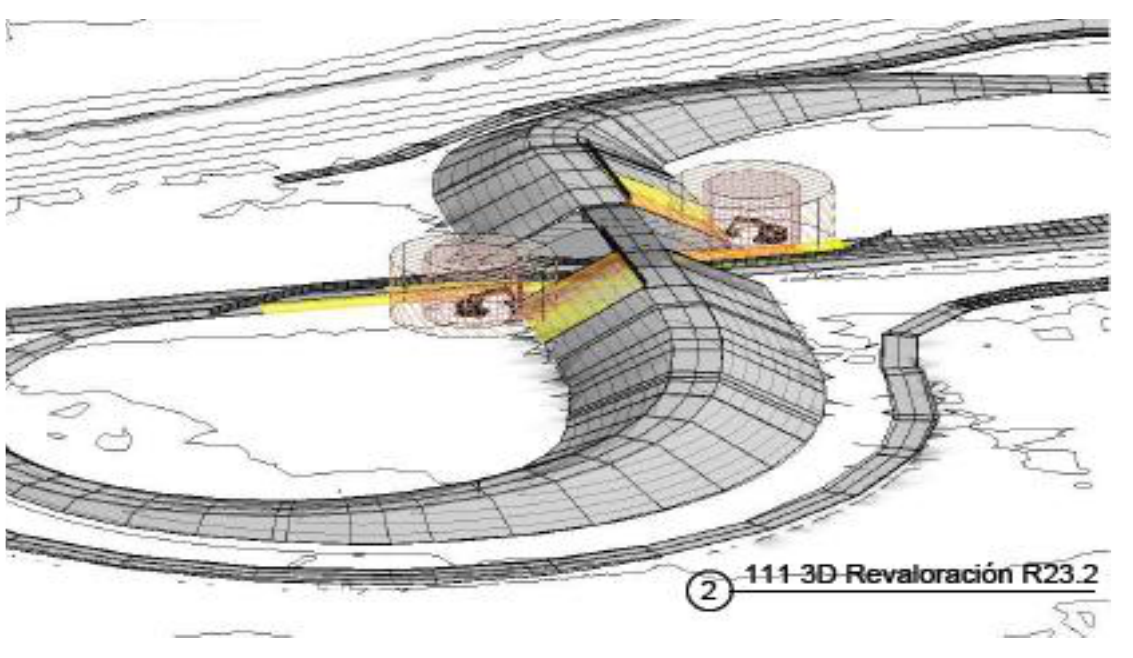
Figure 9. Analysis of specific works. This figure shows the interference between the execution of the refining task of the slopes and the bituminous mixture extension.